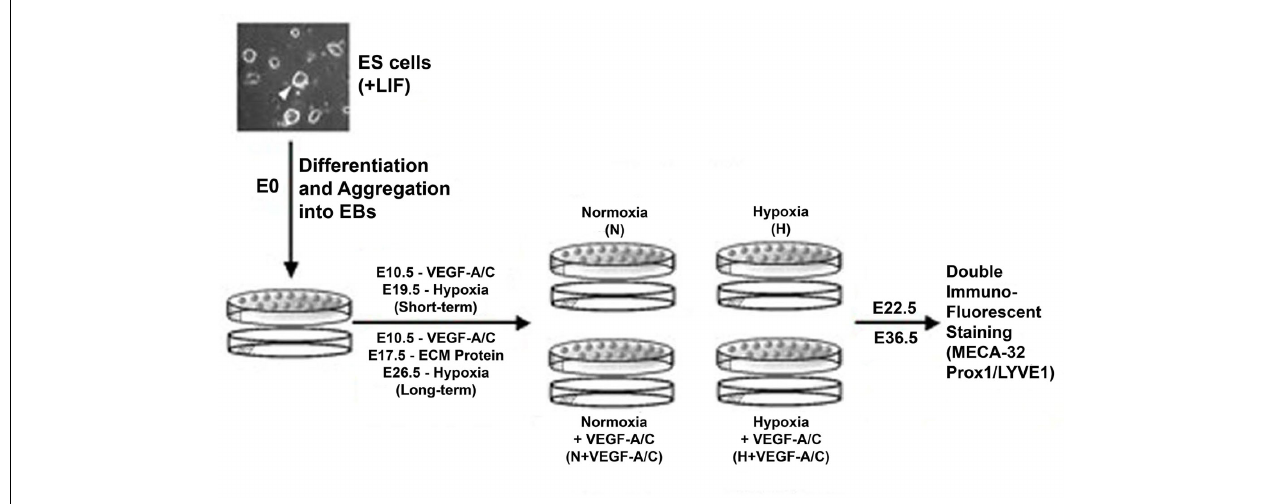
FIGURE 1 | Schematic illustration of the embryoid body (EB) model. The ES cell and EB culture conditions, and the durations of growth factors and hypoxic conditions have been described in the Section “Materials and Methods.” EBs were maintained in normoxia at 21% O 2 and hypoxic EBs were maintained at 2.6% O 2